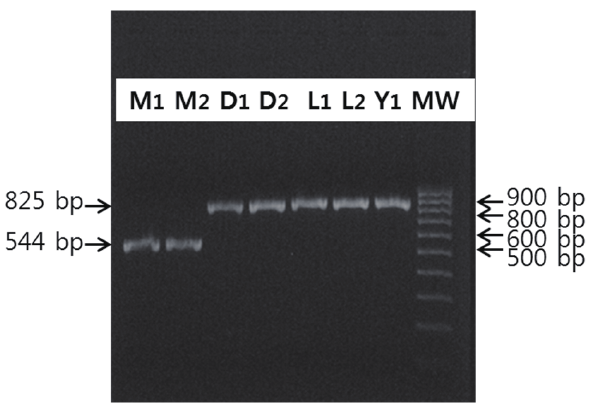
Figure 3. Intron 20 of O-linked N-acetylglucosamine transferase (OGT) from European and Chinese pigs in an independent population at the National Institute of Animal Science (NIAS, RDA, Korea). Fragments containing intron 20 of OGT were compared by amplifying the region containing a part of exon 20, intron 20, and a part of exon 21 of OGT. Polymerase chain reaction amplicons from Meishan (M1, M2) sows were 544-bp, while Duroc (D1, D2), Landrace (L1, L2), and Yorkshire (Y1) sows had only the 825-bp